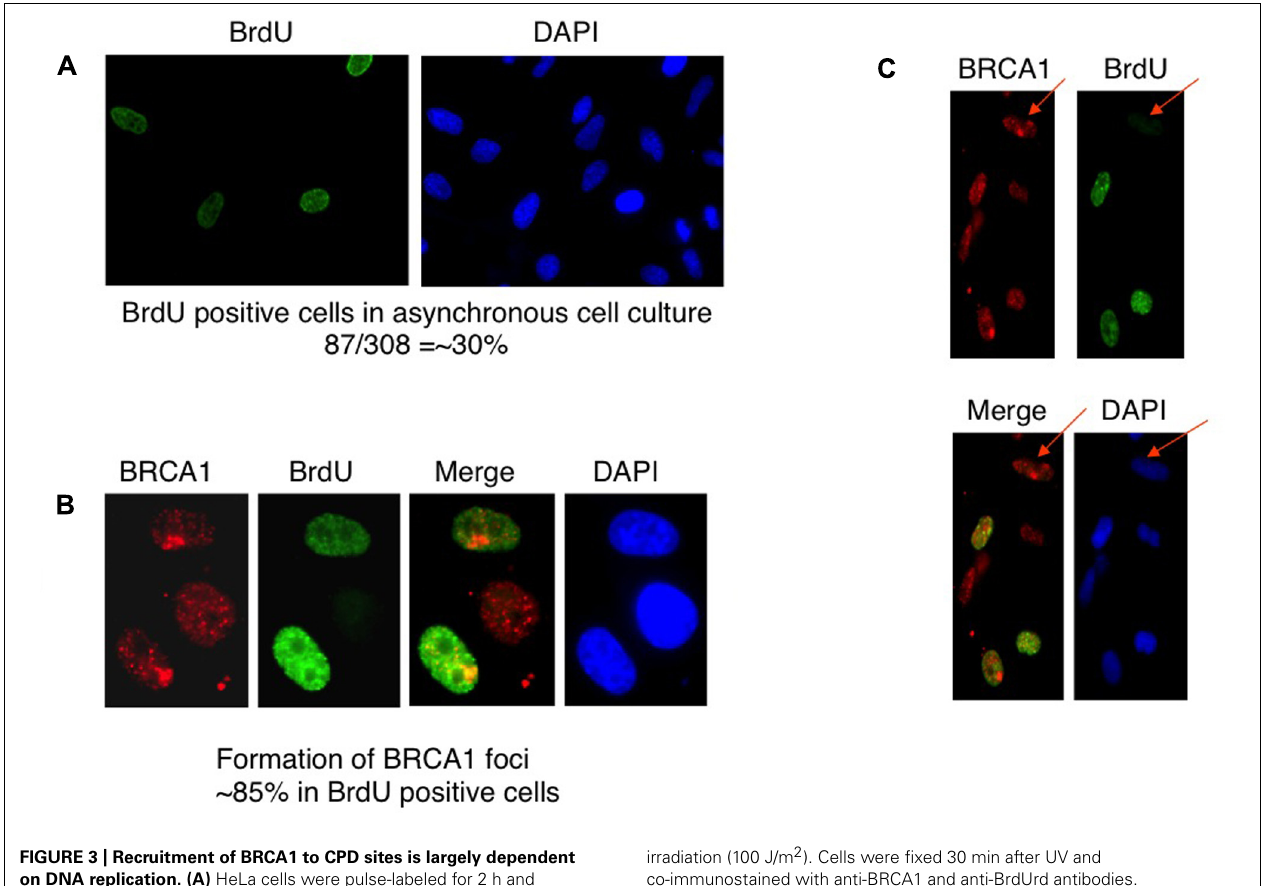
irradiation (100 J/m 2 ). Cells were fixed 30 min after UV and co-immunostained with anti-BRCA1 and anti-BrdUrd antibodies. About 85% of BRCA1 foci are formed in BrdU-positive cells. (C) BRCA1 recruitment to sites of UV damage in non-replicating (BrdU-negative) cells. HeLa cells were pulse-labeled for 2 h and immunostained with anti-BrdU antibody. Arrows indicate BRCA1 focus formation in a BrdU-negative